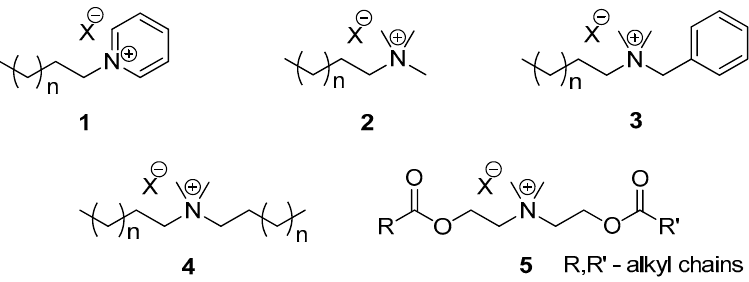
Figure 1. Examples of antimicrobial quaternary ammonium halides: alkylpyridinium ( 1 ); alkyltrimethylammonium ( 2 ); benzalkonium ( 3 ); dialkyldimethylammonium ( 4 ) and diesteralkonium ( 5 ).